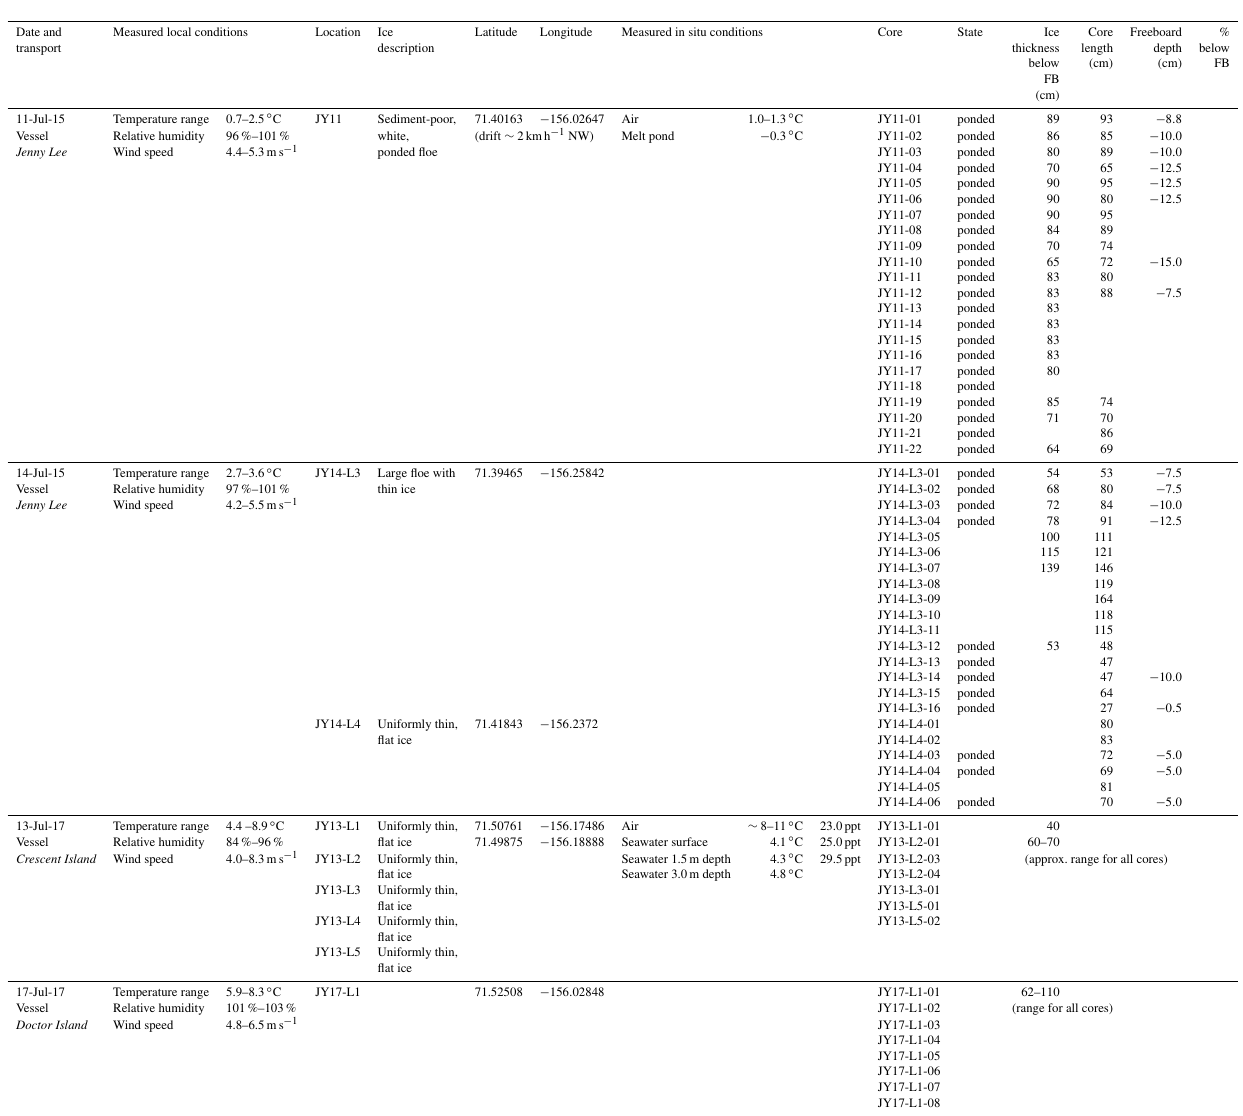
Reconstructed 8-bit 2-D images were analyzed using the software CTAn (Bruker). Cylindrical subvolumes (height = 4 . 0 cm, diameter = 4 . 97 cm) centered on the scanned sam- ple’s z axis were selected from the original scanned sam- ples and positioned to capture a representative segment of the sample, avoiding sample edges. Reconstructed images were parsed into four phases using brightness thresholding determined manually at well-defined phase local minima for each scan: air (black), ice (dark gray), DMP (bright gray), and brine (bright). Phases were manually parsed using cut- offs based on grayscale intensity histograms picked by a